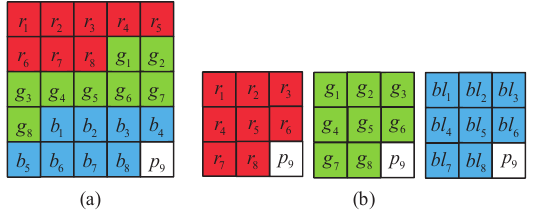
Figure 4. Blocks for sharing true clor image: ( a ) 25-bit B T ( b ) 9-bit B r , B g , B bl